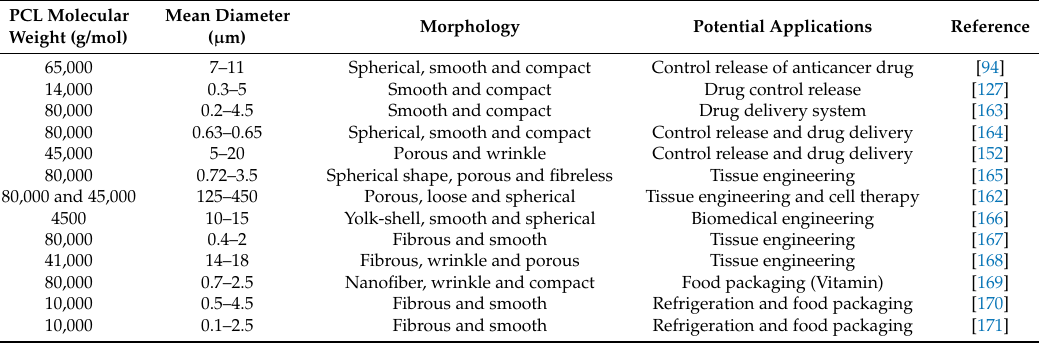
Table 6. Applications of electrosprayed PCL microparticles with different sizes and morphologies. PCL Molecular Weight